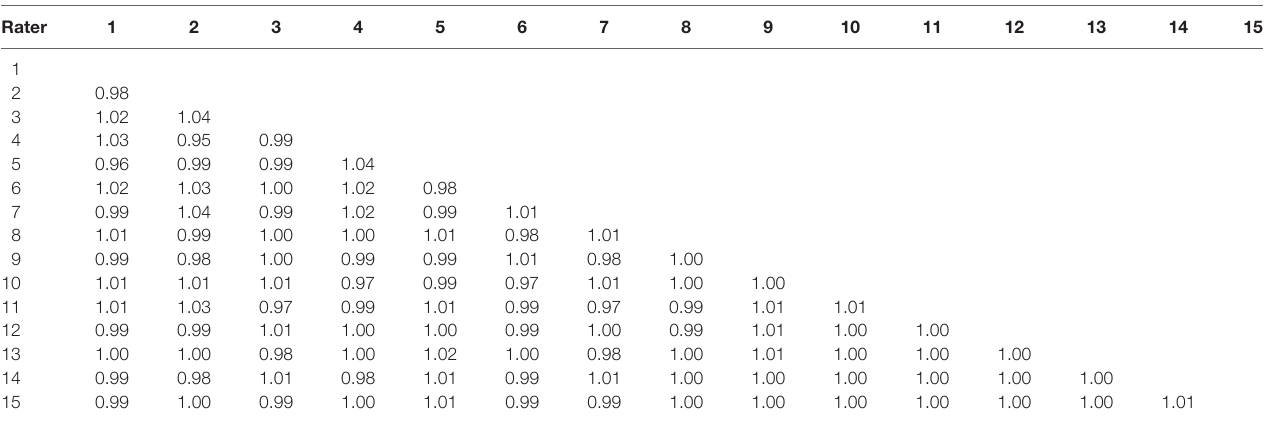
TaBle 6 | Descriptive statistics of the ratings given by individual raters and the MIC estimates of reliabilities, based on ratings of 250 essays.